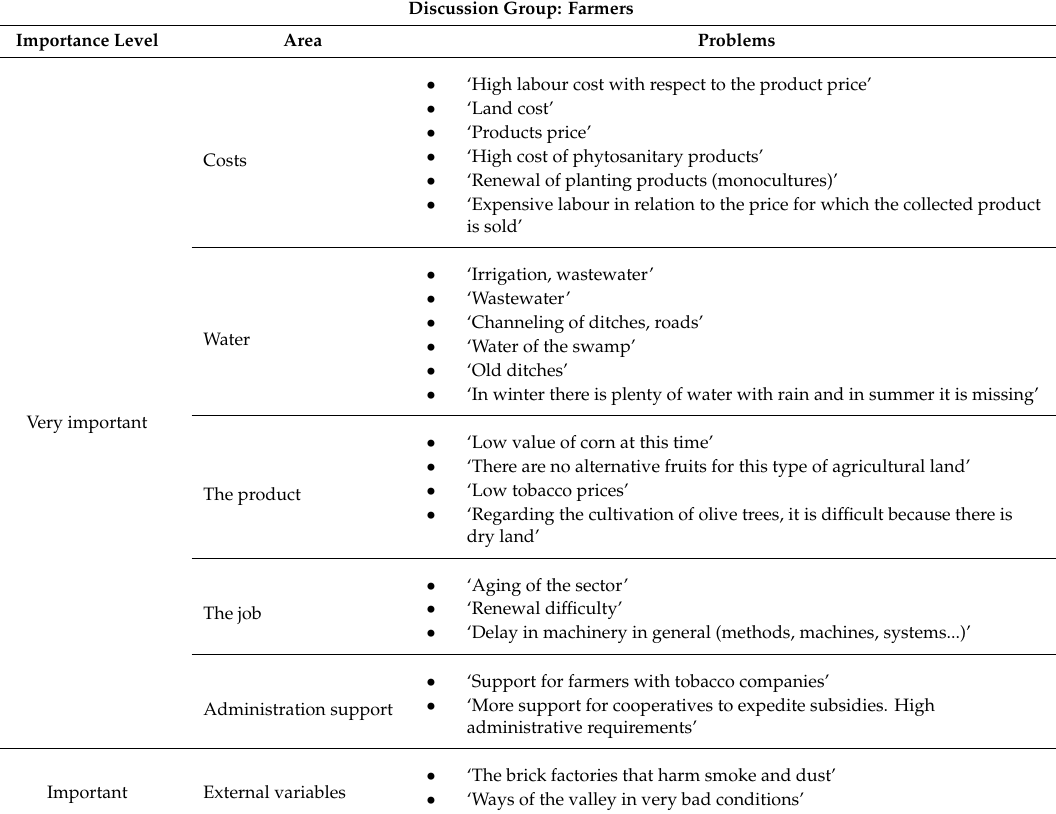
Table 10. Socio-environmental problems extracted from the discussion group